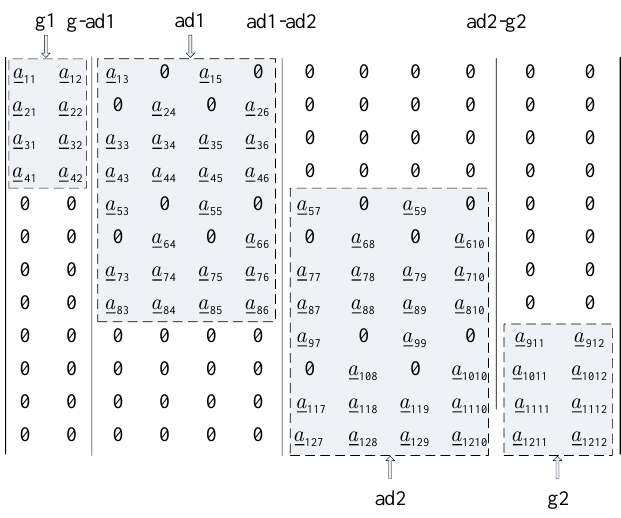
Fig. 2. The complex dispersion equation of models of multilayer gyroelectric- anisotropic-gyroelectric waveguides. The boundaries between the four areas are noted by “g1- ad1”, “ad1-ad2” and “ad2-g2”. “g1-ad1” is the boundary between the gyroelectric core and the first anisotropic dielectric layer. “ad1-ad2” is the boundary between the first anisotropic dielectric layer and the second anisotropic dielectric layer. “ad2-g2” is the boundary between the second anisotropic dielectric layer and the gyroelectric material.